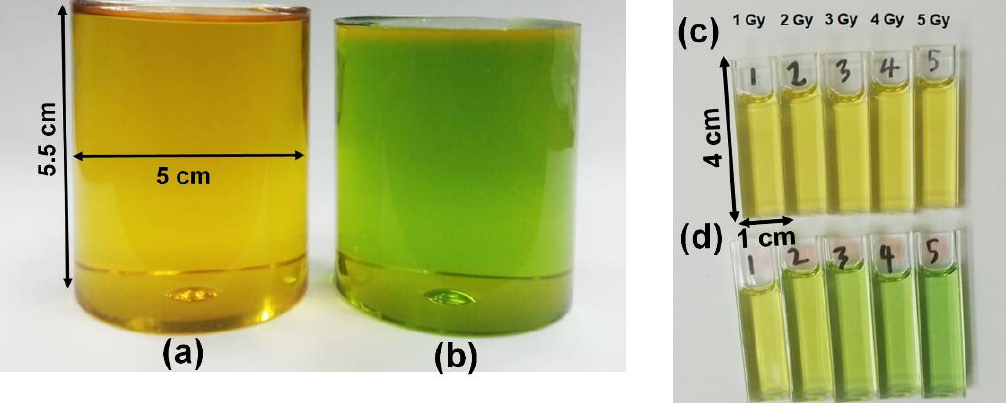
Figure 2. ( a ) The original colour of our batch of PRESAGE is yellow. ( b ) The PRESAGE changes colour to green upon irradiation. ( c ) The original state of PRESAGE in cuvette. ( d ) The colour becomes greener as the dose is increased.